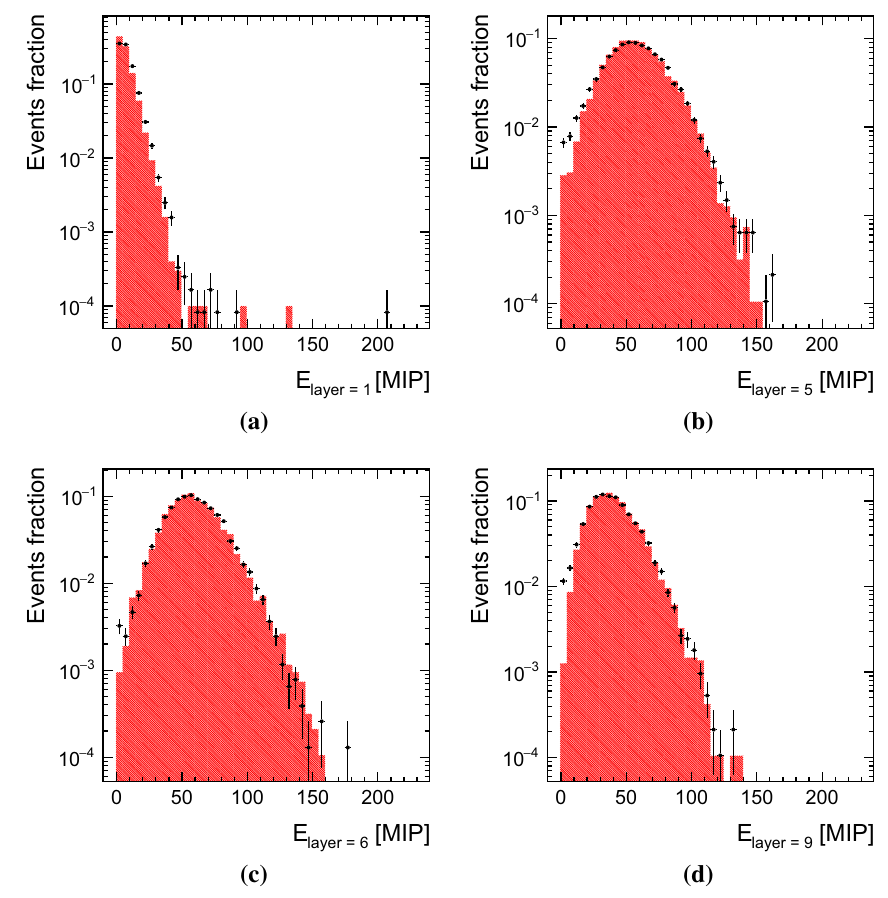
Fig. 18 Distribution of the energy sum per layer, E layer , in MIP units, for layers 1 ( a ) from configuration 1, layers 5 ( b ) and 9 ( d ) from configuration 2 and layer 6 ( c ) from configuration 3. The data (dots) are compared to the MC simulation (shaded region)